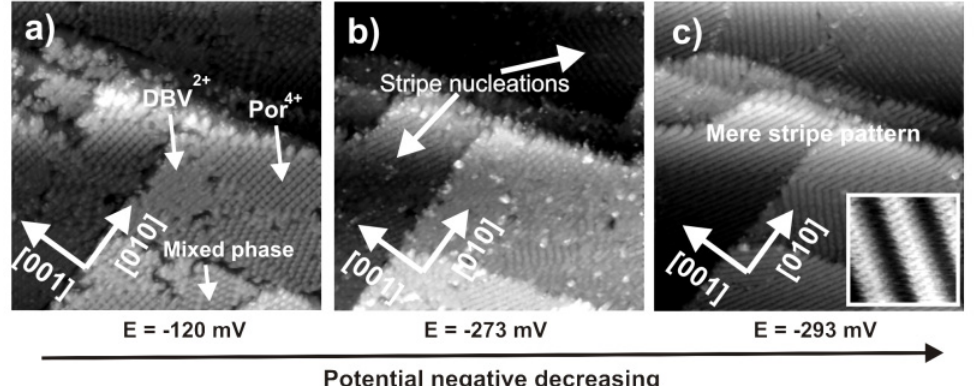
Figure 16. Series of STM images showing the surface transition from the mixed adlayer to the corresponding stripe pattern on the Cl/Cu(100) surface: 76.82 nm × 76.82 nm, = +336 mV, I = 0.1 U b t